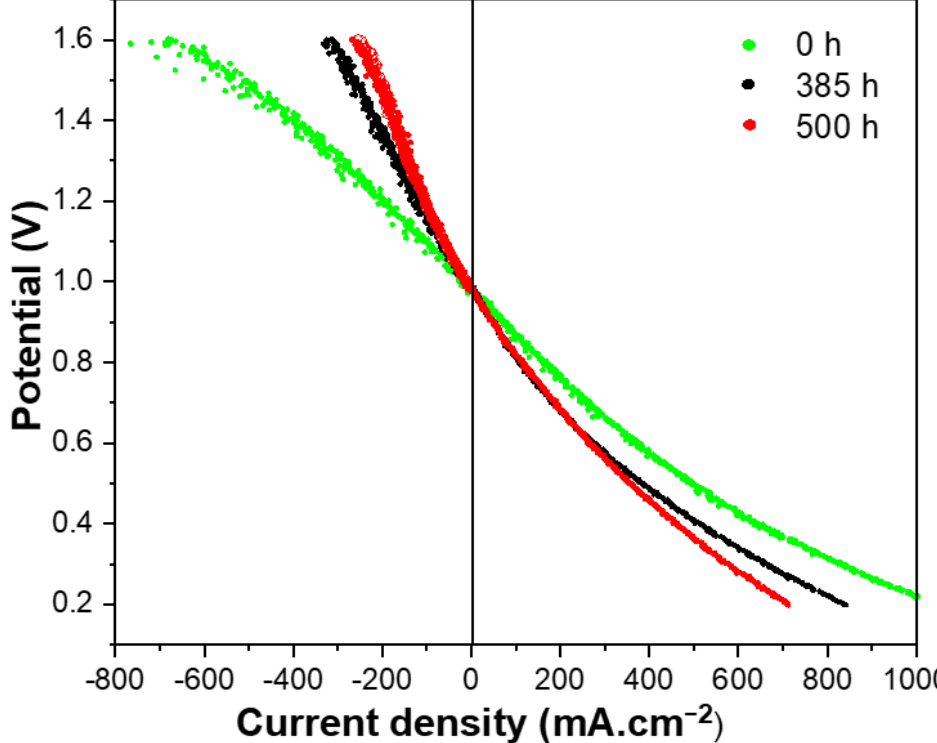
Figure 10. Performance under SOFC and SOEC modes with 50% humidified H 2 at the beginning of long-term operation (t = 0 h), at t = 385 h, and at t = 500 h of operation.